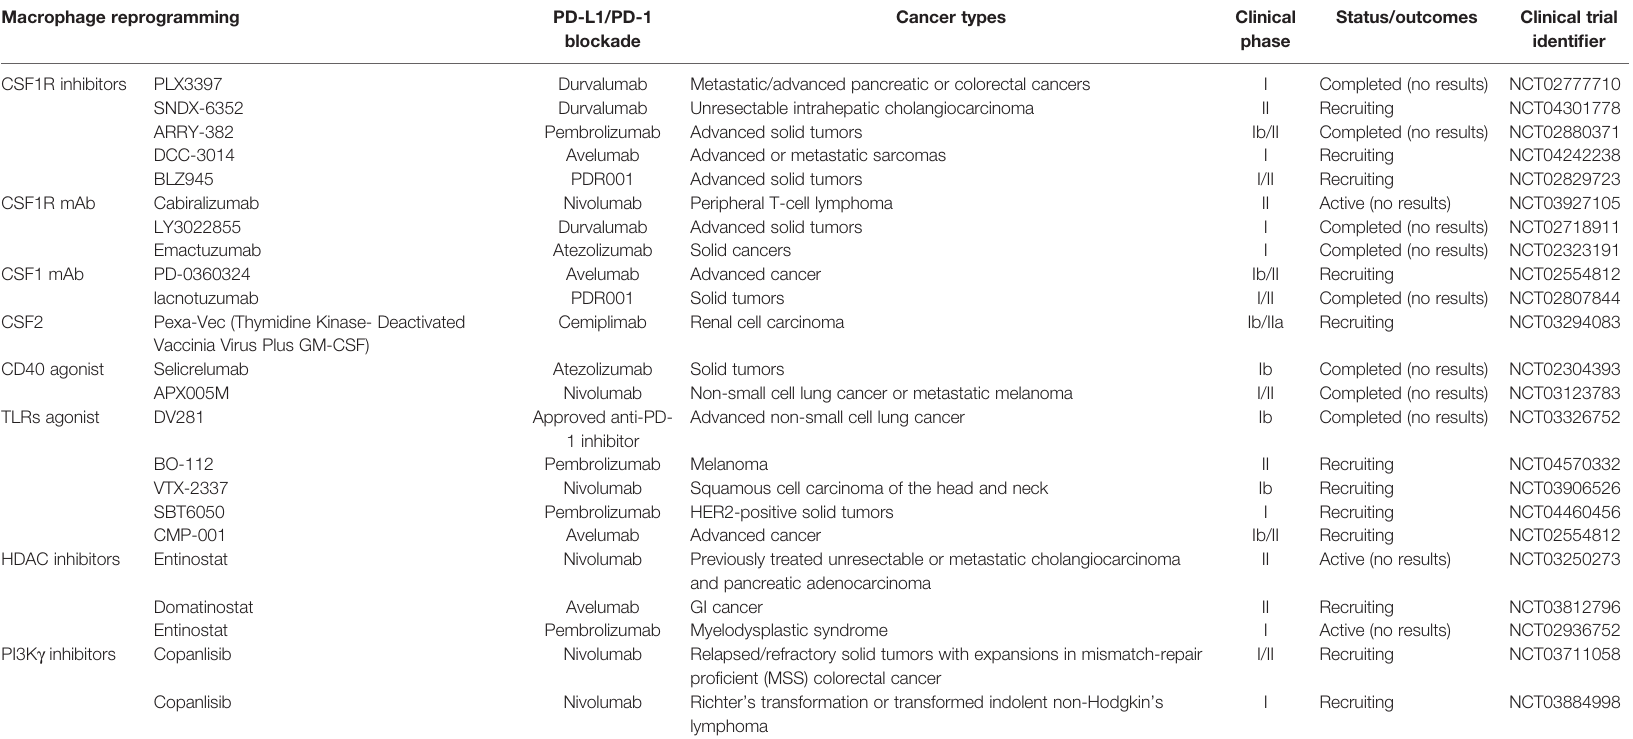
TABLE 1 | Completed and ongoing clinical trials combining macrophage reprogramming and PD-L1/PD-1 blockade in cancer